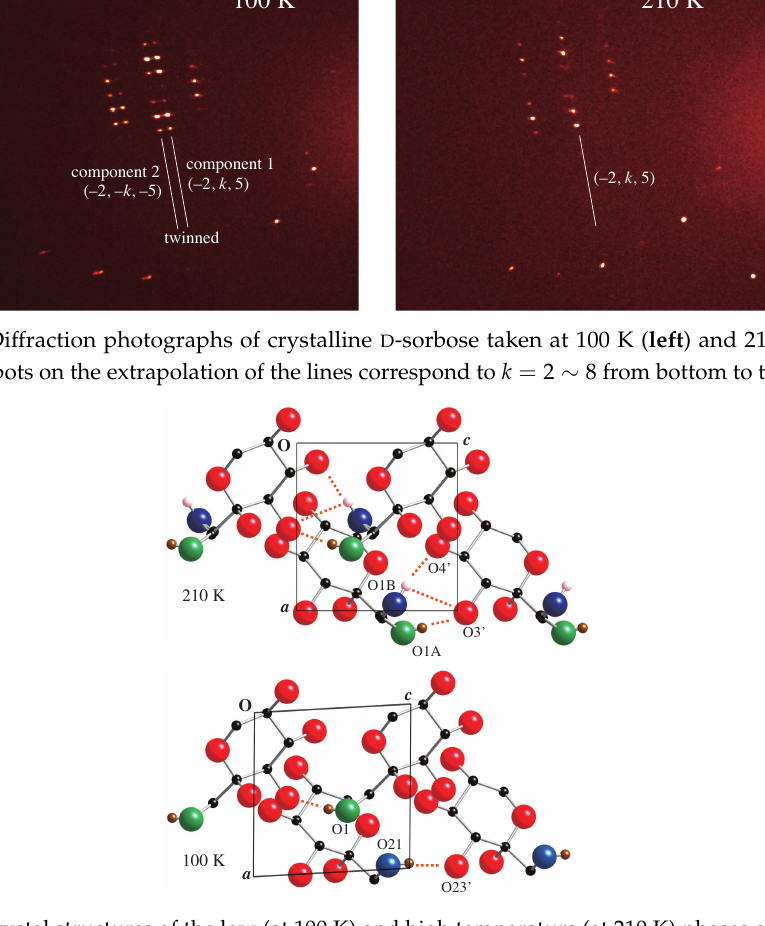
Figure 8. Crystal structures of the low (at 100 K) and high temperature (at 210 K) phases of D -sorbose viewed along the b -axis. Green and blue balls in the top are major and minor components of the disordered oxygen atom in the high temperature phase. Selected hydrogen bonds are shown by dotted lines together with the mediating hydrogen